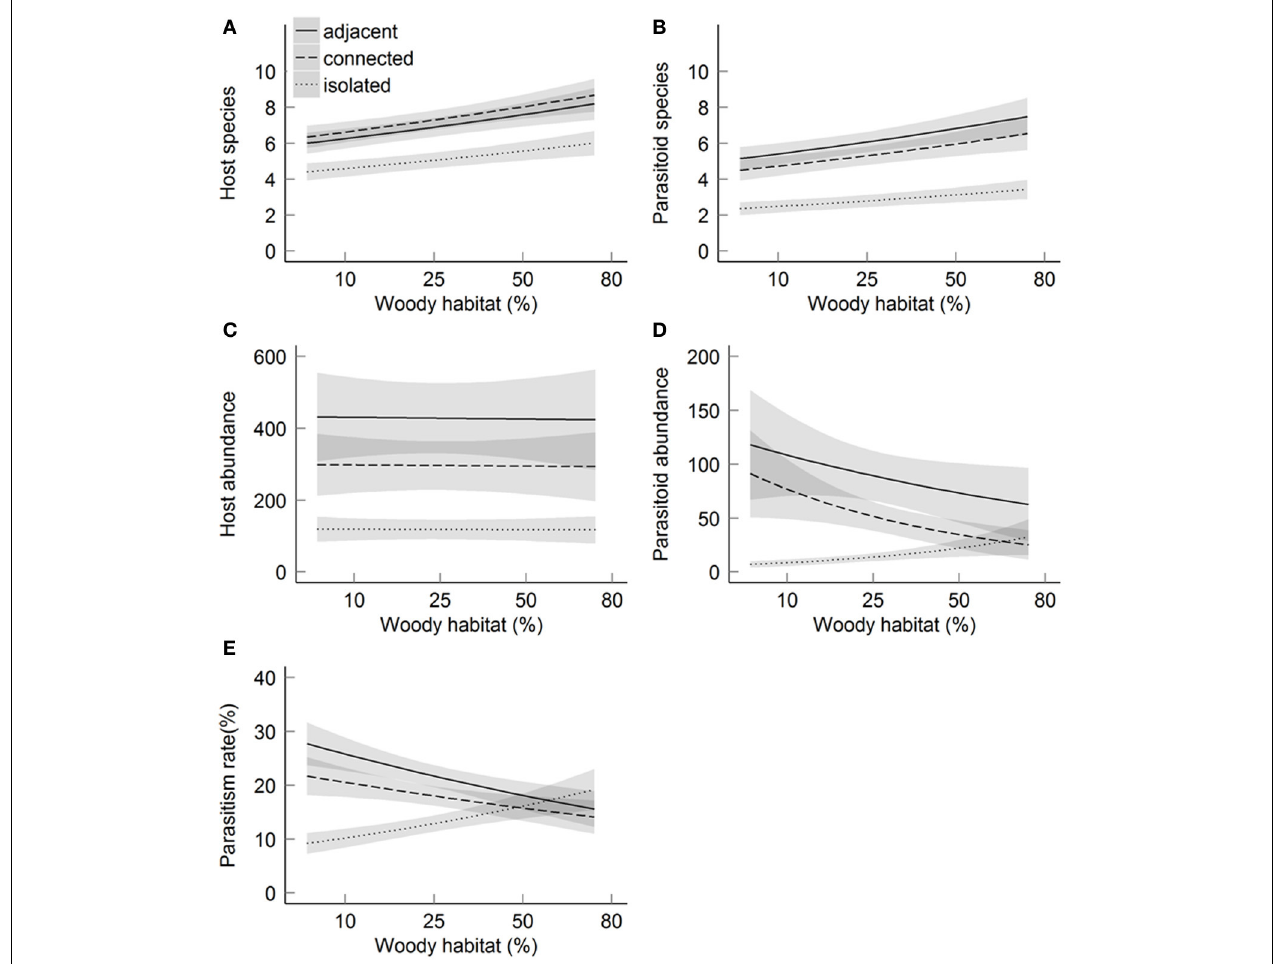
FIGURE 3 | Relationships between the amount of woody habitat within the landscape and host-parasitoid communities in function of the three levels of patch isolation. Host-parasitoid communities were described by the following response variables: number of host species (A) , number of parasitoid species (B) , host abundance (C) ,